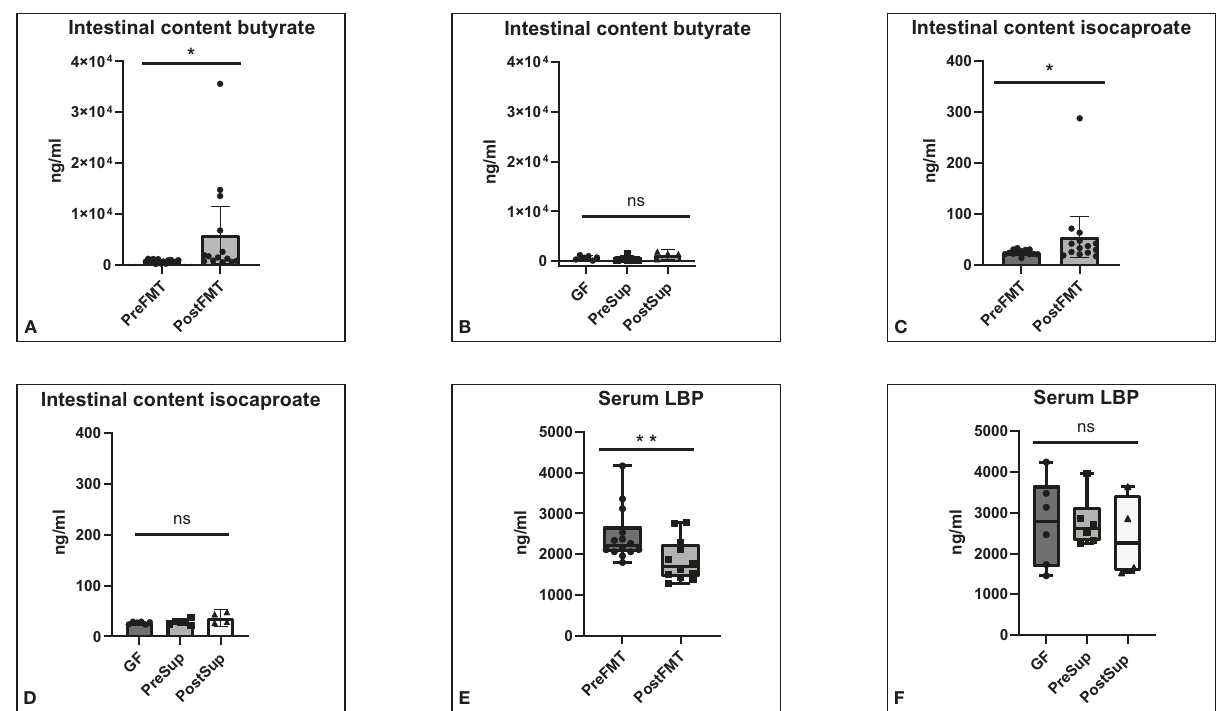
Fig.3|IntestinalcontentsSCFA(short-chainfattyacids)increasedwhileserum LBP decreased with post-FMT stool colonization compared to pre-FMT. A Butyrate after colonization with entire stool, B Butyrate in germ-free mice and those colonized using sterile supernatants from pre and post-FMT mice. C Isocaproate after colonization with entirestool, D Isocaproate ingerm-free mice and those colonized using sterile supernatants from pre and post-FMT mice. Data presentedasmeanand95%CI(boxplot)withindividualvaluesandtheentirerange in the error bars. E Serum lipopolysaccharide binding protein (LBP) reduced after